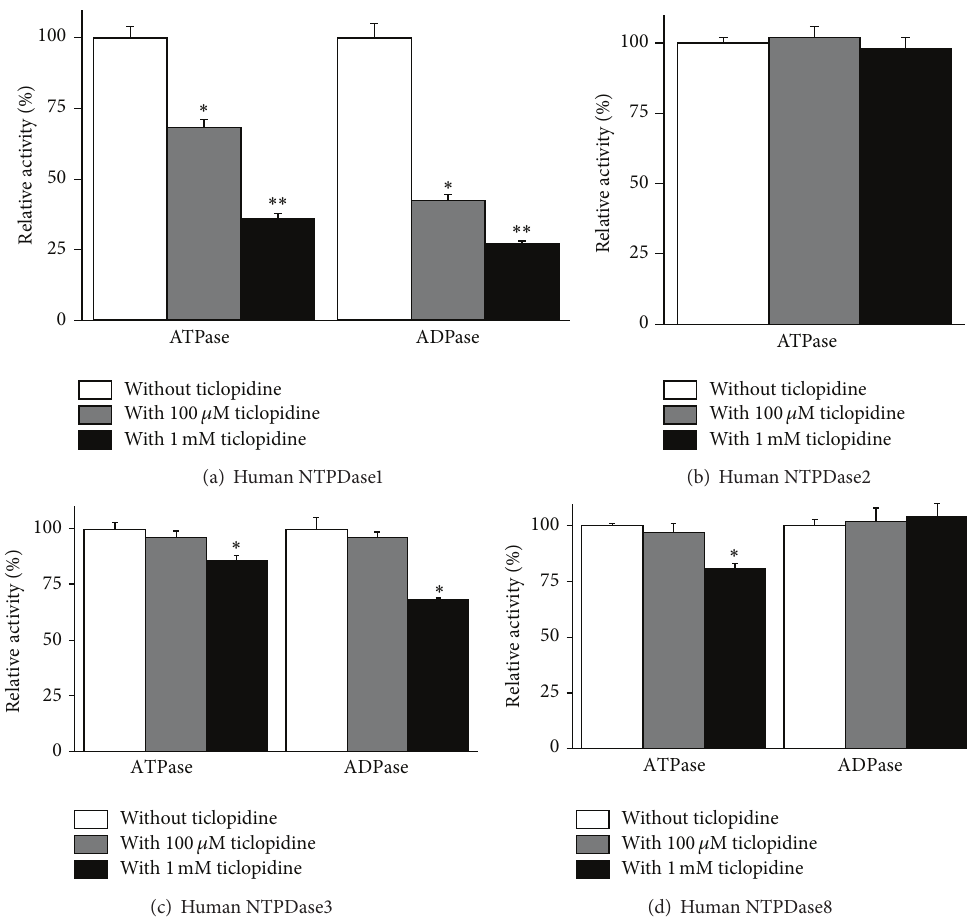
Figure 2: Influence of ticlopidine on recombinant human NTPDase activities. Enzymatic assays were carried out with lysates from COS- 7 cells transfected with an expression vector encoding the indicated enzyme. The substrate (ATP or ADP at the concentration of 100 𝜇 M) was added alone or together with ticlopidine at the concentration of either 100 𝜇 M or 1mM. The 100% activity in the absence of ticlopidine corresponded to the following: for human NTPDase1 to 670 ± 29 and 550 ± 21 nmol P i ⋅ min −1 ⋅ mg protein −1 for ATP and ADP as substrates, respectively (a), for human NTPDase2 to 1023±58 nmol P i ⋅ min −1 ⋅ mg protein −1 for ATP as substrate (b), for human NTPDase3 to 256±37 and ⋅ min −1 ⋅ mg protein −1 for ATP and ADP as substrates, respectively (c), and for human NTPDase8 to 148±16 and 33±6 nmol 103±10 nmol P i P i ⋅ min −1 ⋅ mg protein −1 for ATP and ADP as substrates, respectively (d). Data are presented as the mean ± SD of 3 experiments carried out in triplicate. ∗ 𝑃 = 0.018 ; ∗∗ 𝑃 = 0.0002